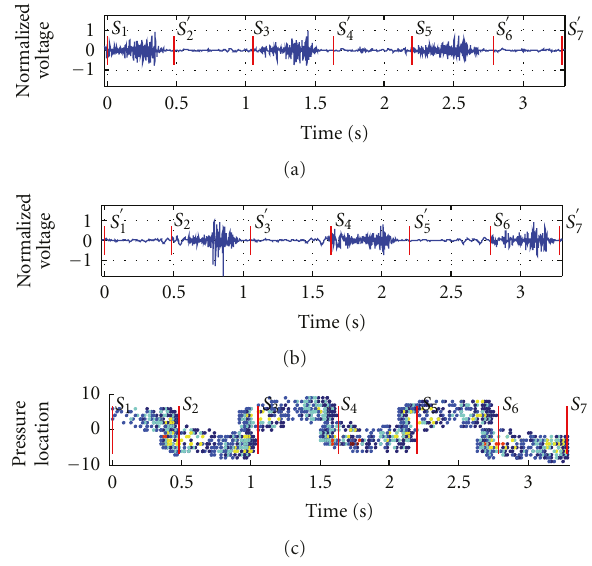
Figure 5: Signal representation of (a) left gastrocnemius (b) right gastrocnemius, and (c) pressure walkway recording, with swing phase divisions shown in red for nonhypertensive subject 001 walk